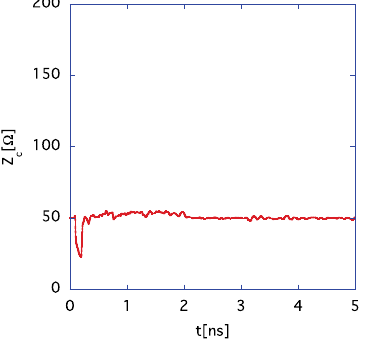
electrode.FIG. with the FIG. 14. The simulation result for the exponential electrode with (blue) and without (red) apron. FIG. 15. Schematics of the concave pentagon electrode with a dent at z ¼ x 0 toward the chamber. Top view (the upper left), side view (the upper right) and front view (the lower) of the